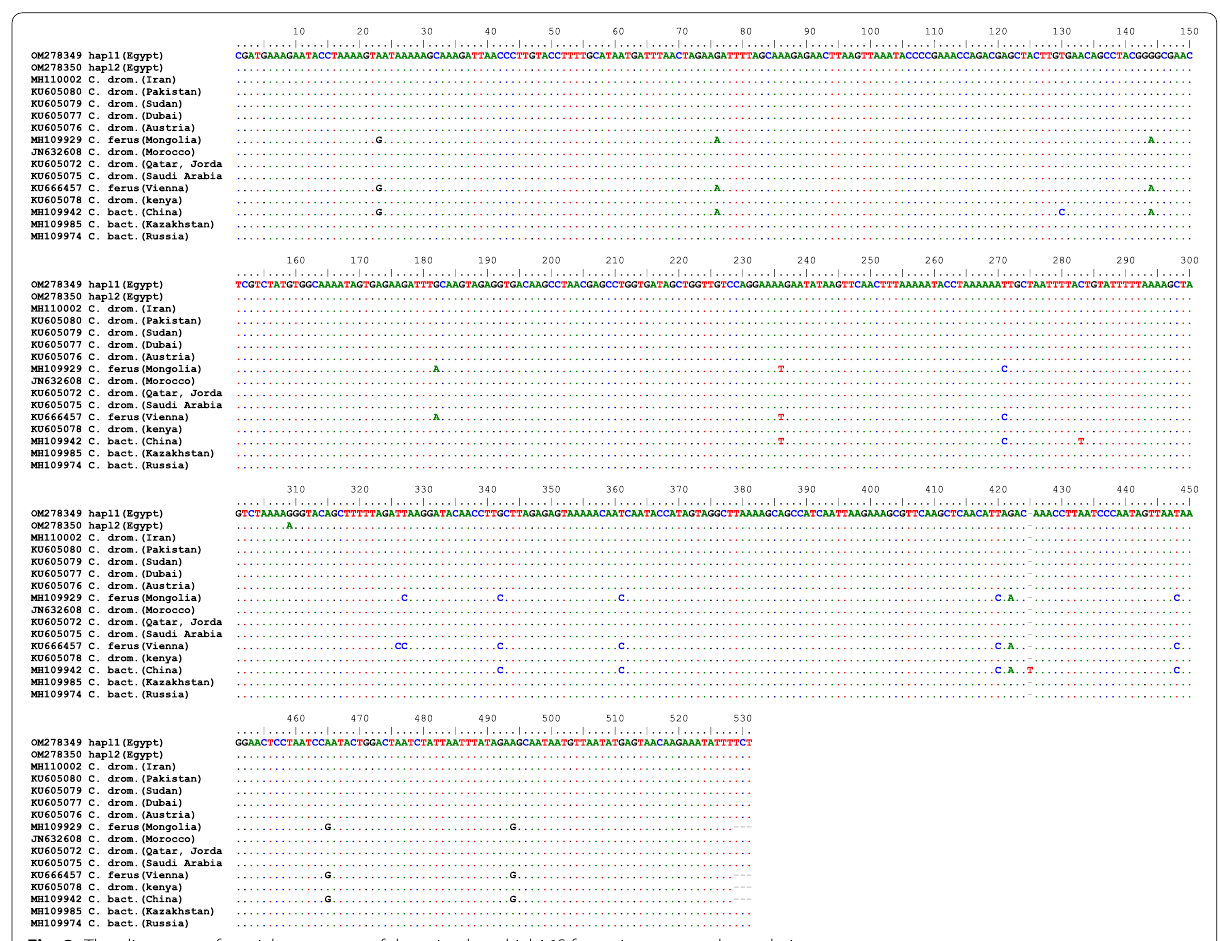
Fig. 3 The alignment of partial sequences of the mitochondrial 16S from sixteen camel